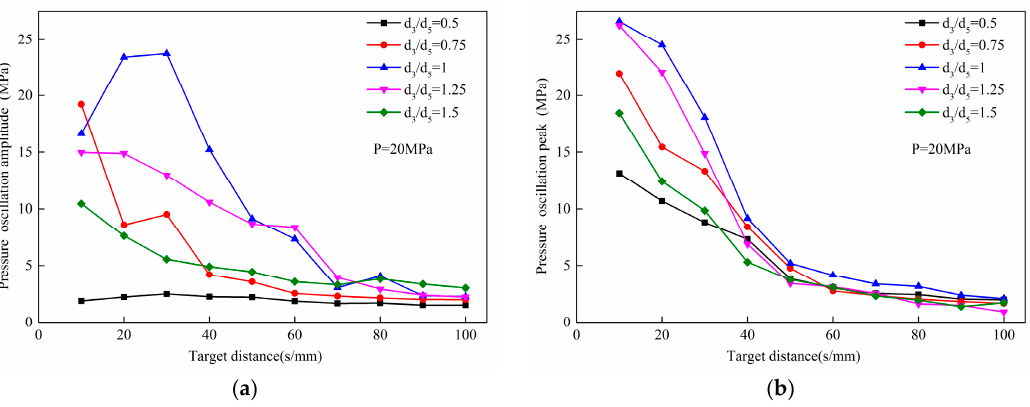
Figure 16. Effect of d 3 / d 5 on nozzle performance at 20 MPa pressure. ( a ). curves of nozzles with different d 3 / d 5 on pressure pulsation amplitude at different target distances. ( b ). curves of nozzles with different d 3 / d 5 on pressure oscillation peak at different target distances.